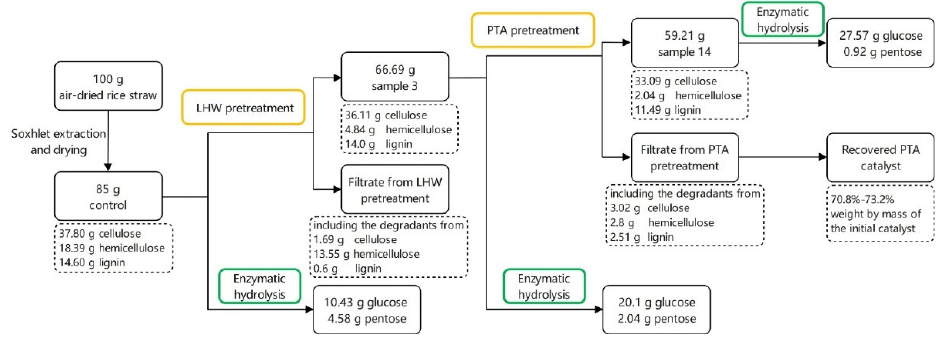
Figure 5. Mass balance diagram of rice straw before and after LHW ‐ PTA pretreatment.